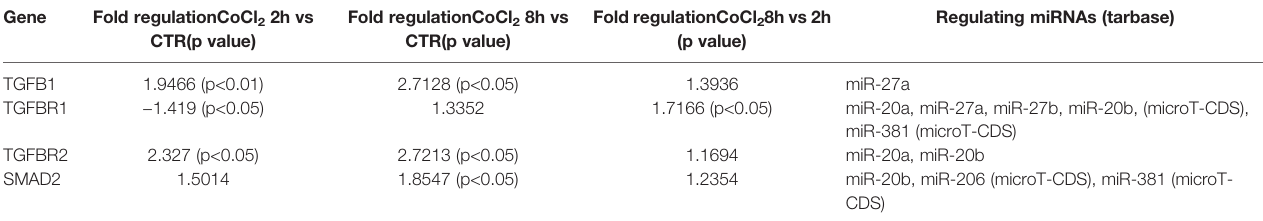
TABLE 1 | Differential expression of genes of the TGF b signaling pathway.